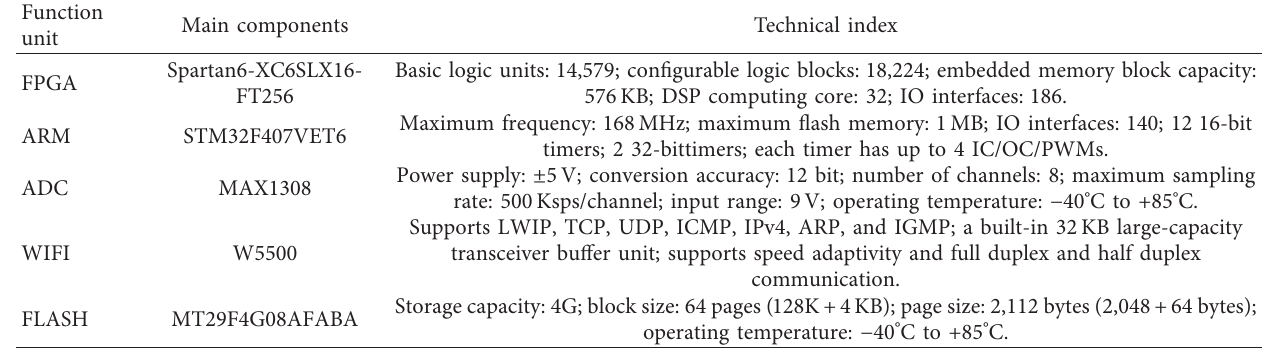
Table 1: Indicators of key devices.